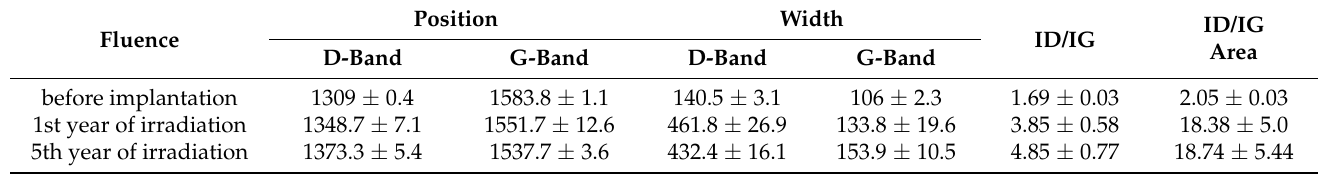
Table 2. The average values obtained from six samples of S-3 p-TRISO buffer layer.